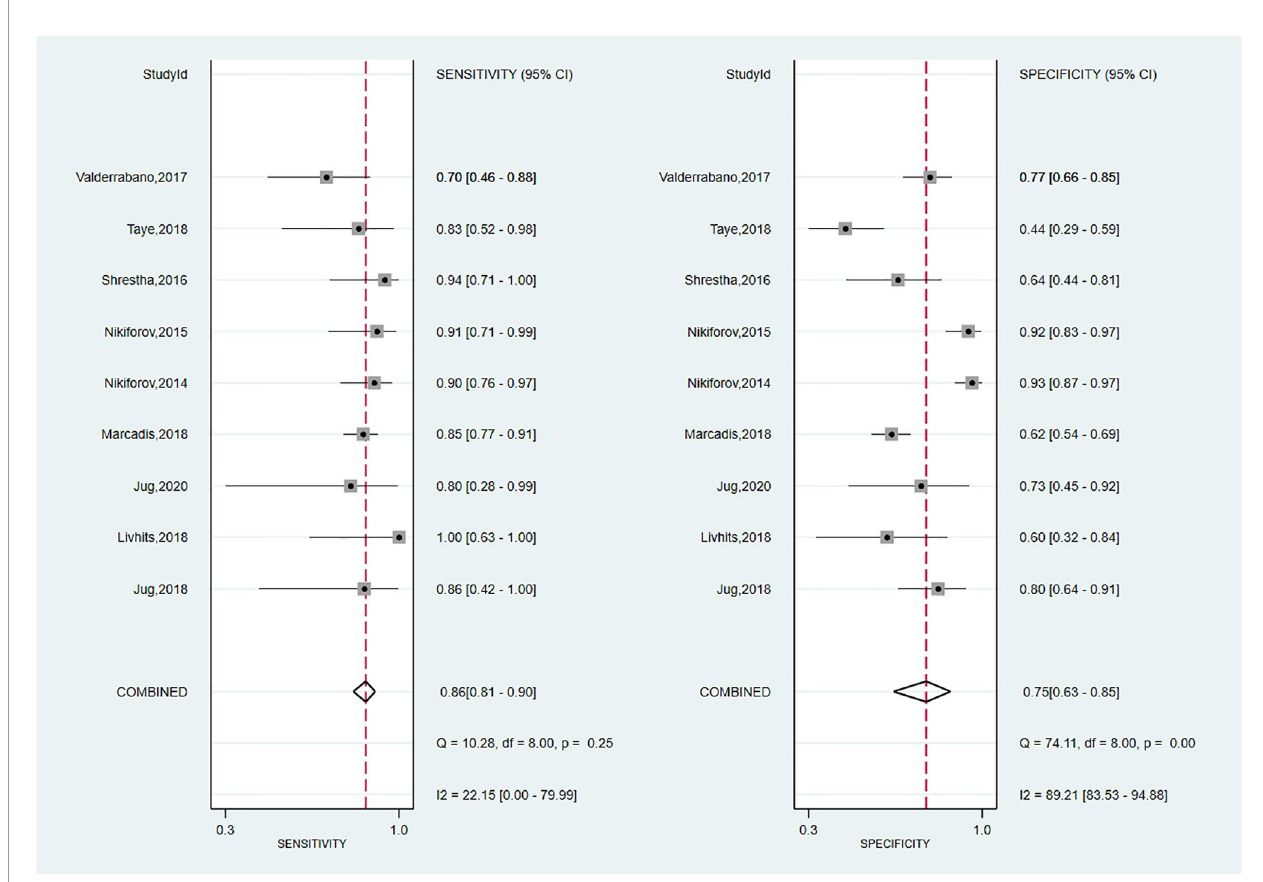
FIGURE 5 | Forest plot of sensitivity and speci fi city for Thyroseq v2